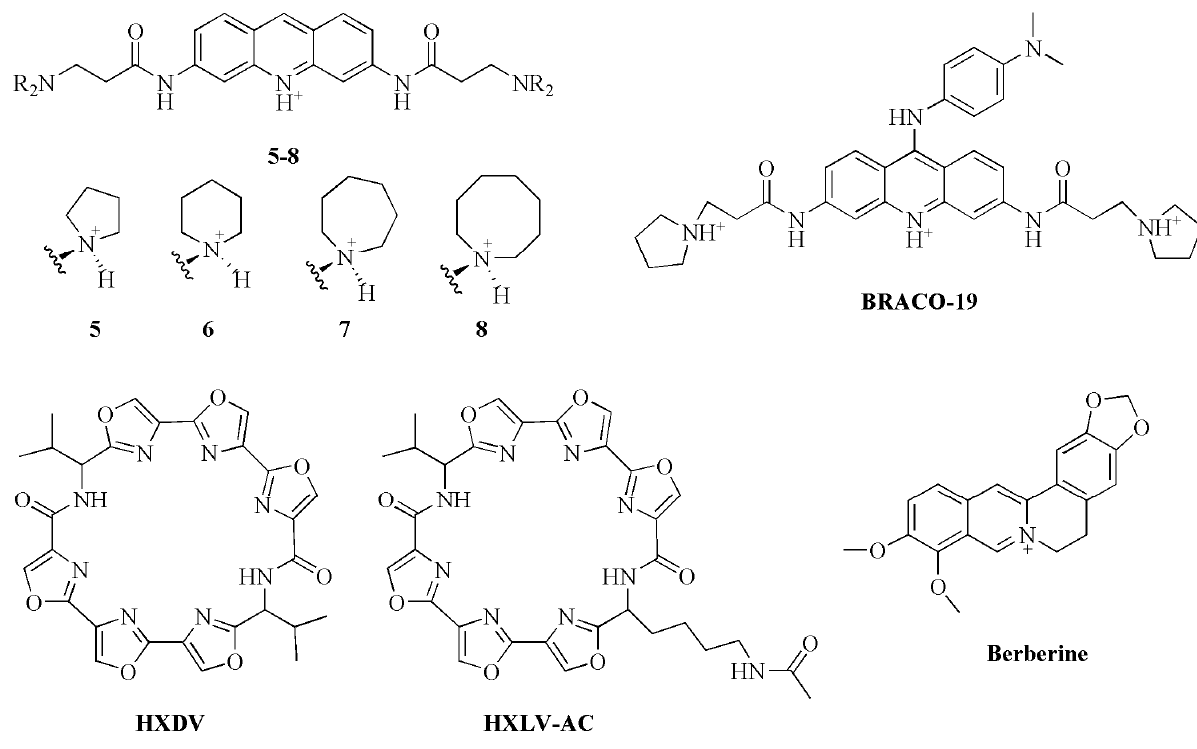
Figure 3. Chemical structures of quadruplex-interactive compounds studied by